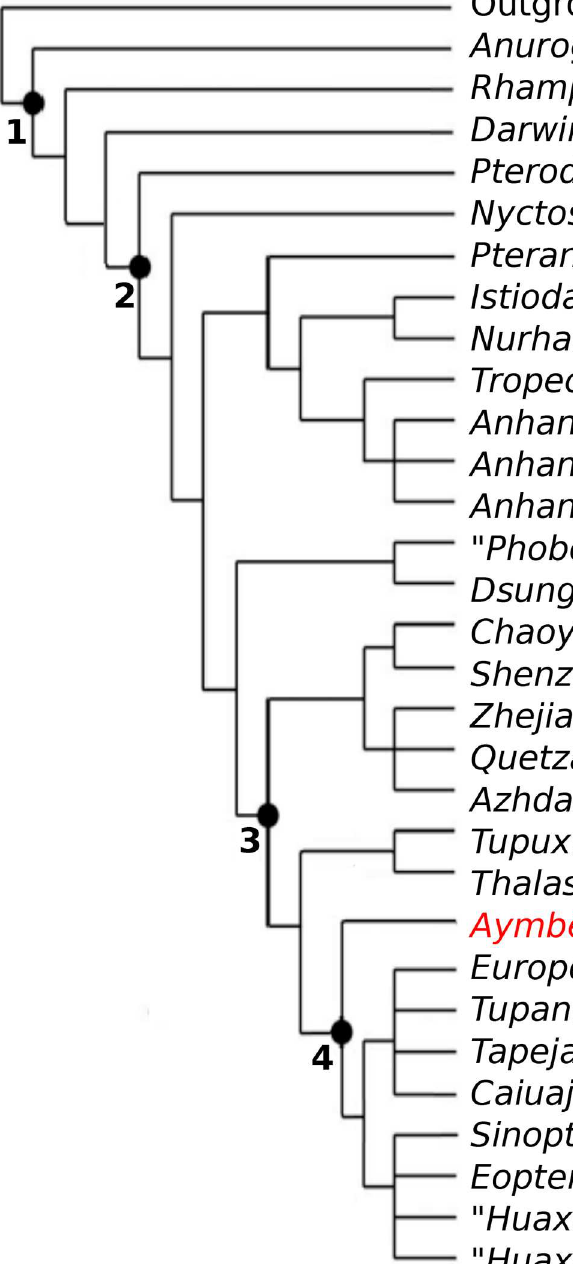
Fig 6. Phylogenetic analysis. Modifiedversion (see text) of the matrixby [7], with the inclusionof Aymberedactylus cearensis gen. et sp. nov. Nodes:1, Pterosauria;2, Pterodactyloidea;3, Azhdarchoidea; 4,